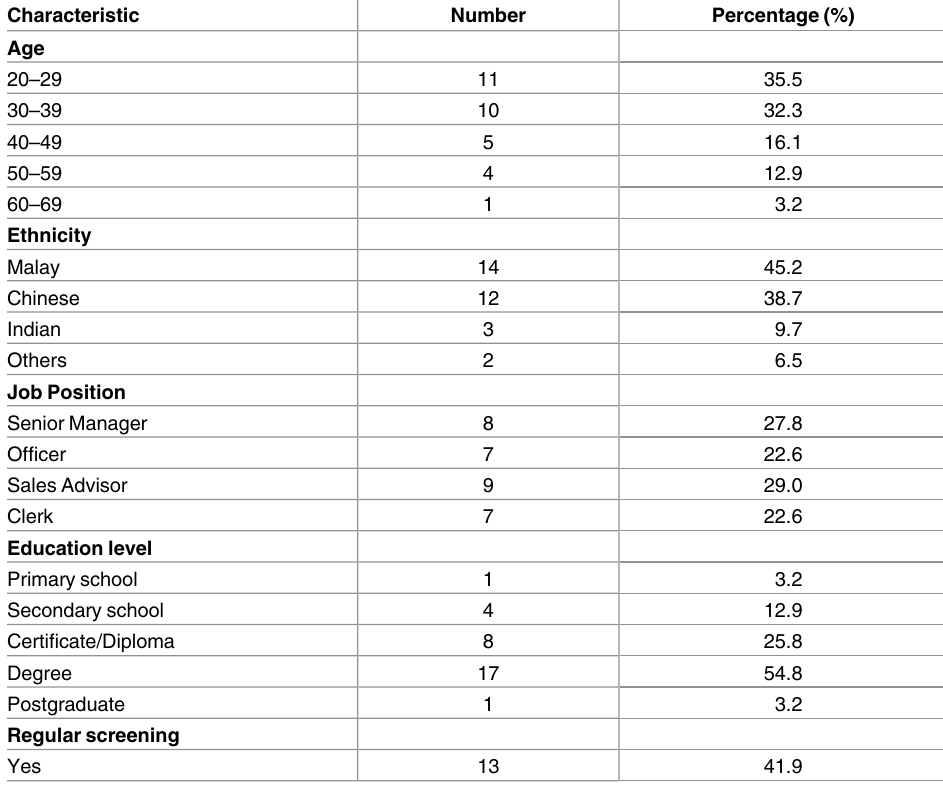
Table 1. Characteristics of all